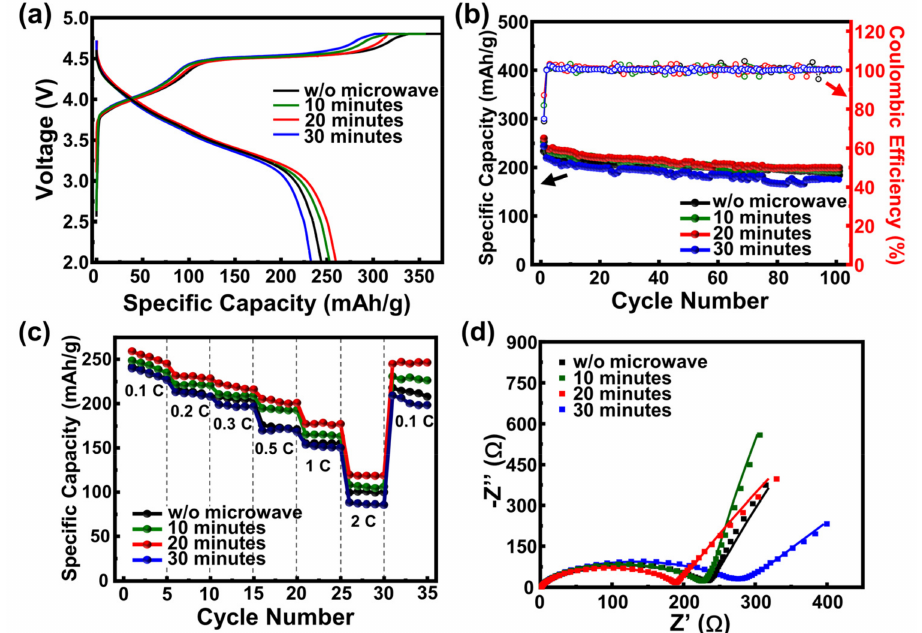
Figure 4. ( a ) Initial charge–discharge profile and ( b ) cycling stability of all LNCM samples, measured at a current density of 0.1 C (20 mA/g, 2–4.8 V) during the first activation cycle, followed by 100 cycles at 0.2 C (40 mA/g, 2–4.6 V); ( c ) rate capability of all LNCM samples, measured at various current densities within the 2–4.8 V voltage window; and ( d ) Nyquist plots of all LNCM